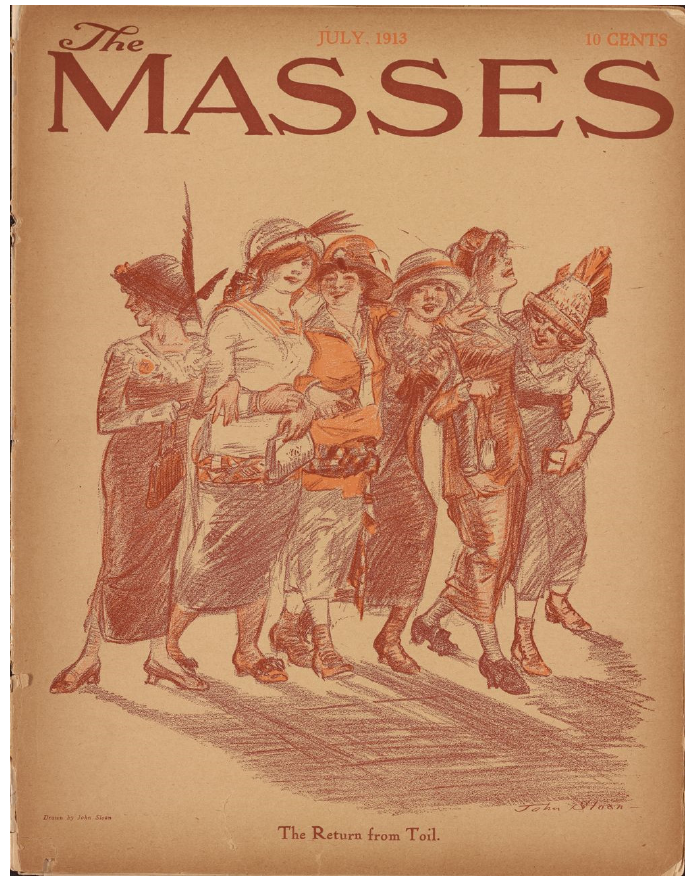
Figure 31. John Sloan. Cover image: The Return from Toil. The Masses V. 4 No. 10 (July 1913). The Modernist Journals Project. Available online: https://modjourn.org/issue/bdr527257/ (accessed on 29 August 2022).